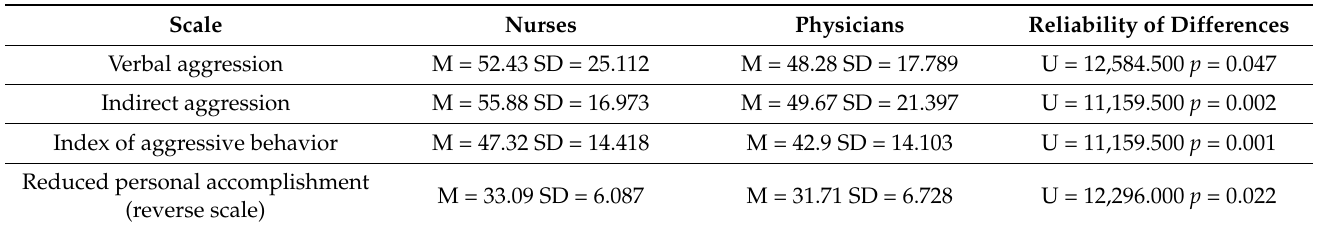
Table 12. Assessment of the average values of the level of reduction of personal achievements, components of aggression (physical, verbal, indirect, aggressive behavior) in non-COVID-19 ICU HCWs. M is the mean value, SD is the standard deviation, U is the Mann–Whitney criterion, and p is the significance level.